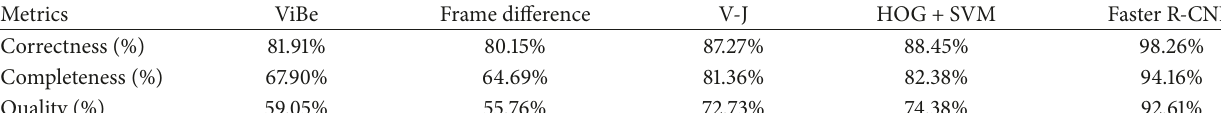
Table 2: Vehicle detection under illumination changing condition.